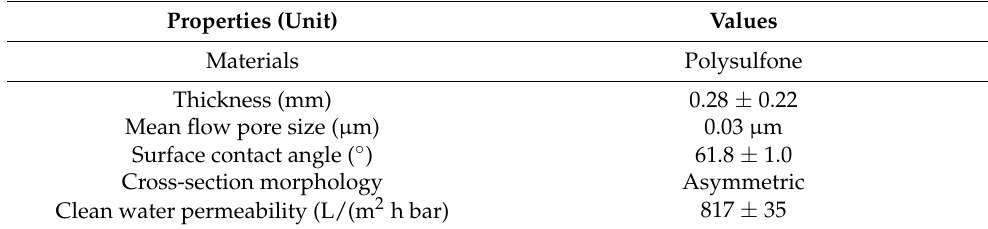
Table 2. Summary of membrane properties used in RBC-ME configuration.